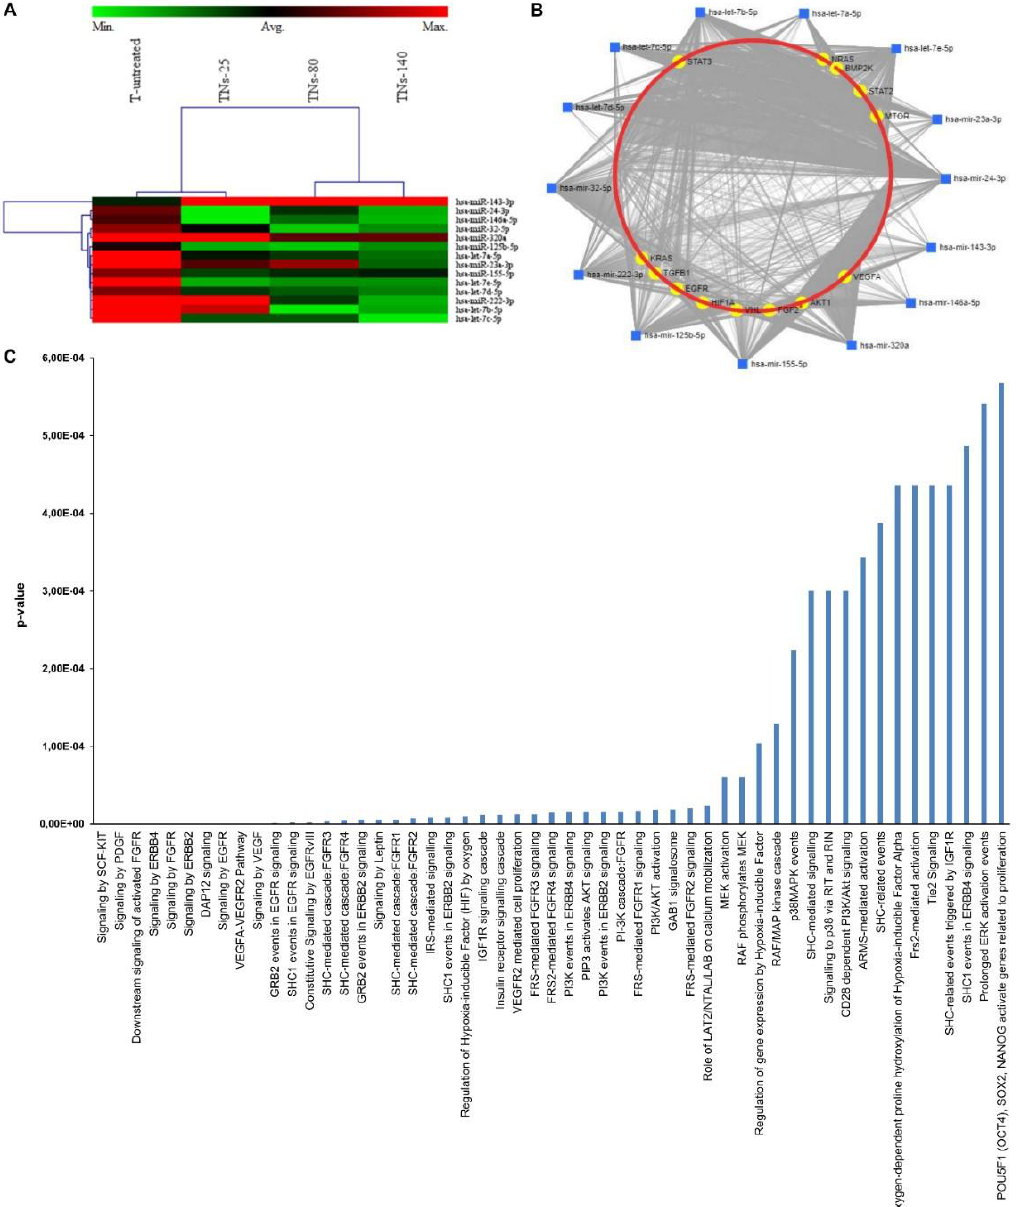
Figure 8. ( A ) Heat map showing the differential expression of miRNAs in TN surfaces versus control group (T-untreated) based on miRNA PCR arrays data. Columns and rows indicate the samples and the specific miRNAs, respectively. Red to green colors indicate the magnitude of gene expression changes. ( B ) The mRNA-miRNA signaling network visualized using miRNet (http://www.mirnet.ca/). Blue squares represent the 14 differentially expressed miRNA, yellow circles indicate the target mRNAs, and their relationship is represented by lines. ( C ) Pathway enrichment analysis using the Reactome software (http://reactome.org). Reactome pathways are displayed on the x -axis, and the corresponding p -value is shown on the y